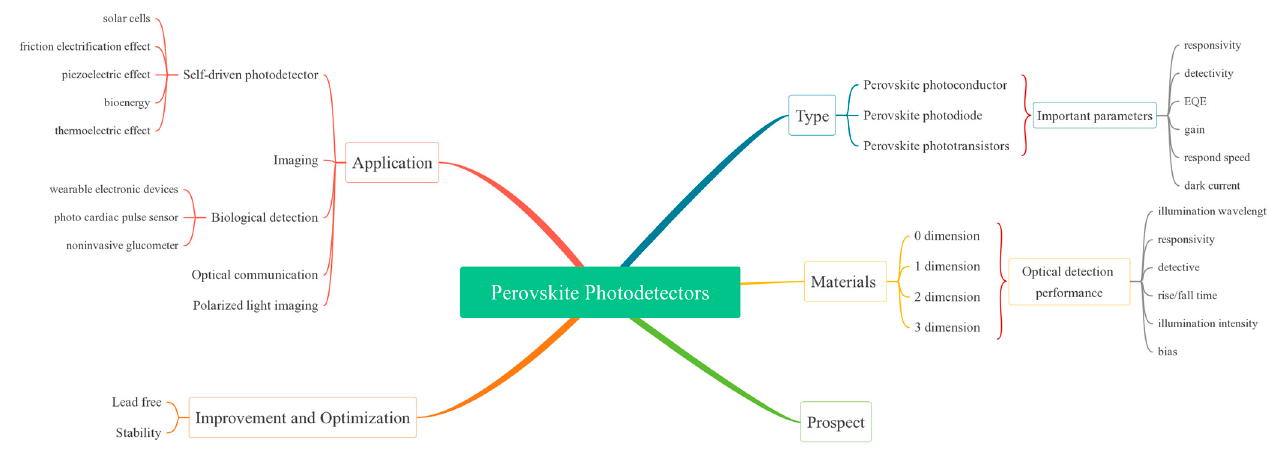
Figure 1. The roadmap of current